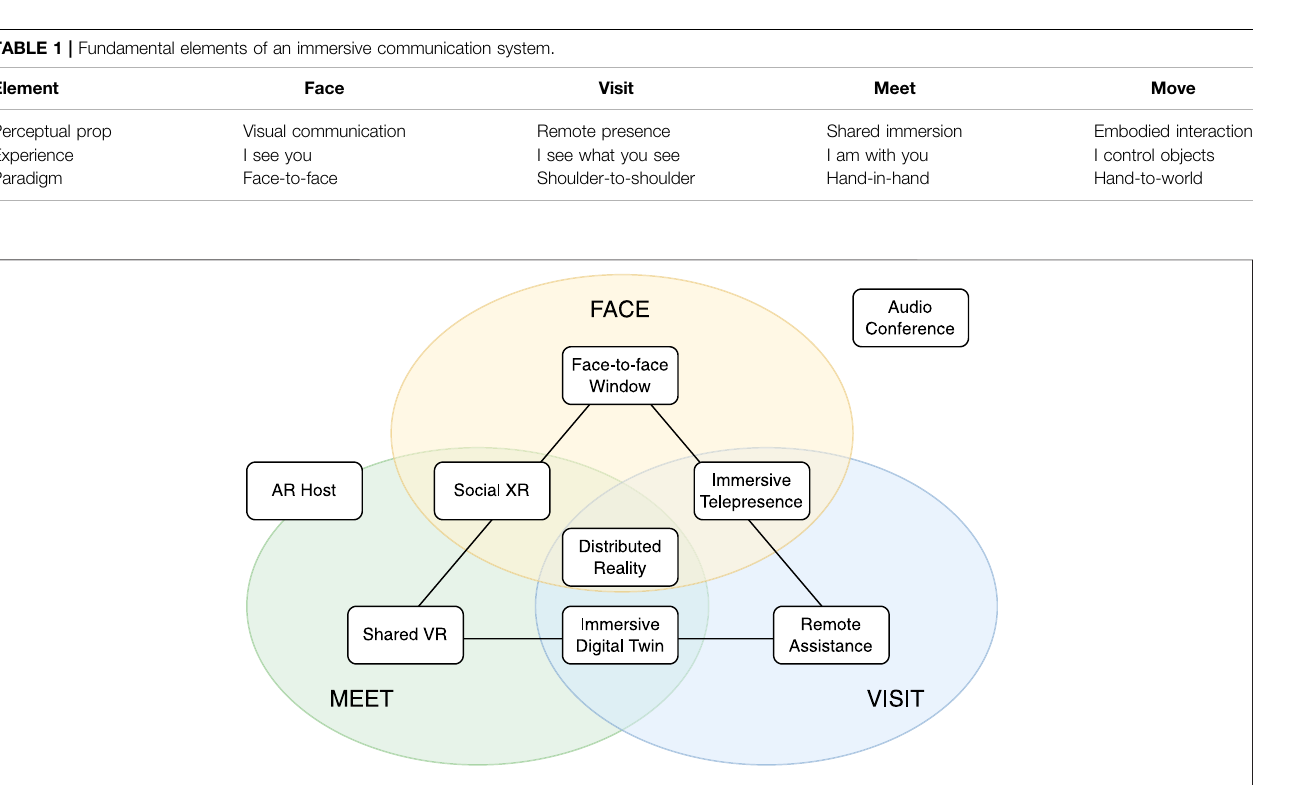
FIGURE 2 | Archetypes of immersive communication